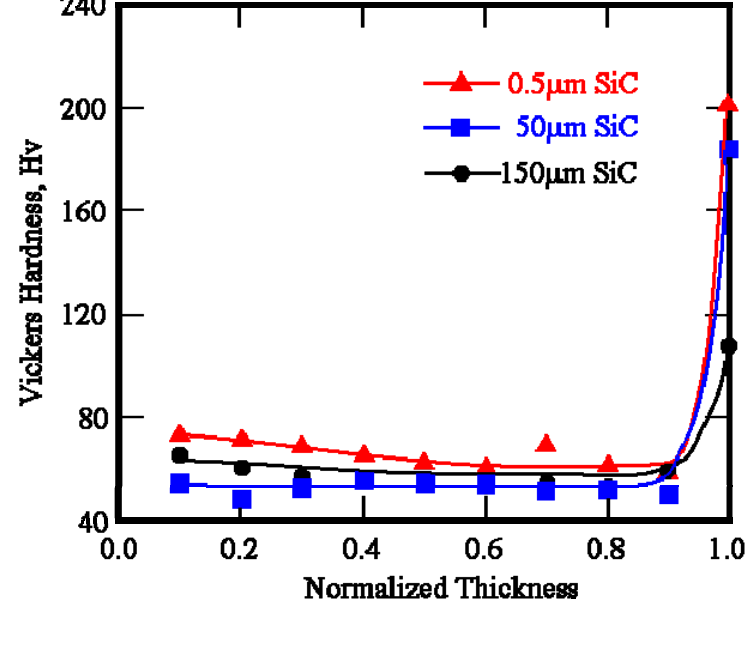
Figure 11. Vickers hardness of Specimens 1, 2 and 3 as a function of normalized thickness